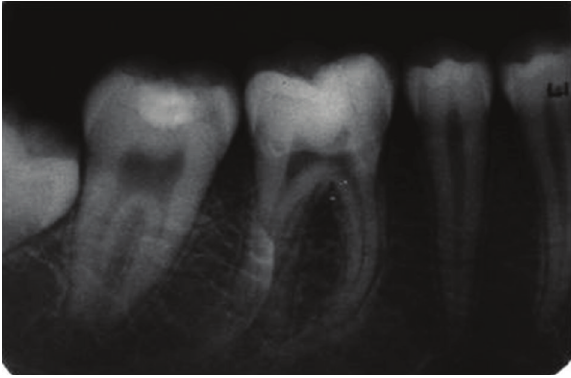
Figure 31: Intraoral periapical radiograph with 46 at 2 years followup. No significant pulpal or periapical changes.